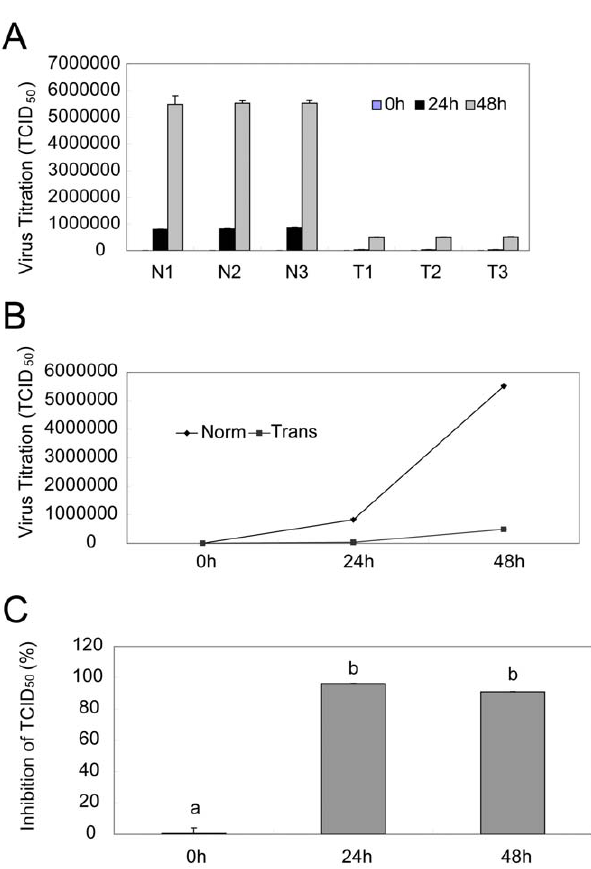
Figure 5. shRNAs degradation of viral RNA in primary transgenic bovine tongue epithelium cells. The primary bovine tongue cells were isolated from three normal (N1, N2, N3) or three transgenic (T1, T2, T3), respectively, and inoculated with 100 TCID 50 , viral samples were taken at 0 h, 24 h and 48 h, respectively, and viral RNA was determined with real-time RT-PCR, the relative amount viral RNA in three normal (N1, N2, N3) or three transgenic (T1, T2, T3) primary bovine tongue cells from three independent experiments was computed using ABI Prism 7000 SDS Software (Applied Biosystems) (A), the average amount viral RNA was compared between normal (Norm) and transgenic (Trans) groups (B), and its inhibition by shRNA in transgenic cells was evaluated as compared to normal controls (C). The standard used was 10-fold dilutions of 10 7 TCID 50 of virus ml 2 1 . Duncan’s multiple range test by SAS 8.0 system, means with the same letter are not significantly different (P . 0.01).